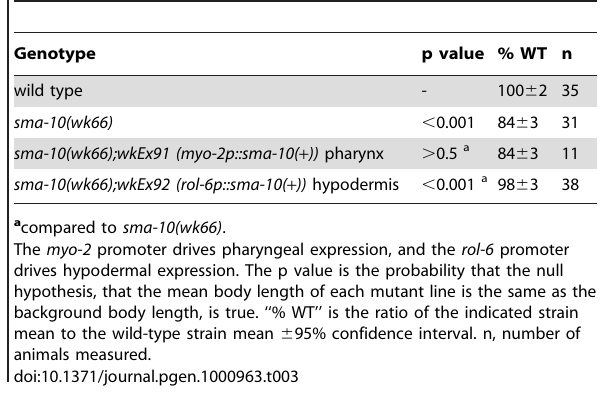
Table 3. Hypodermal sma-10 expression rescues the body size defect of sma-10(lf)